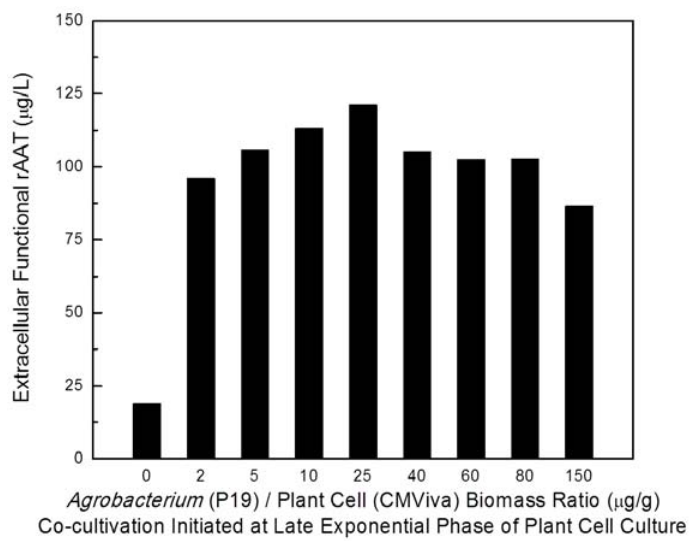
Figure 6. Effect of biomass ratio (0, 2, 5, 10, 25, 40, 60, 80 and 150 μ g/g) of Agrobacterium to transgenic plant cells (CMViva) on rAAT production in shake flasks at 20 °C. Co ‐ cultivation was initiated in the late exponential phase of plant cell culture. Samples were taken on day 8 post ‐ induction.